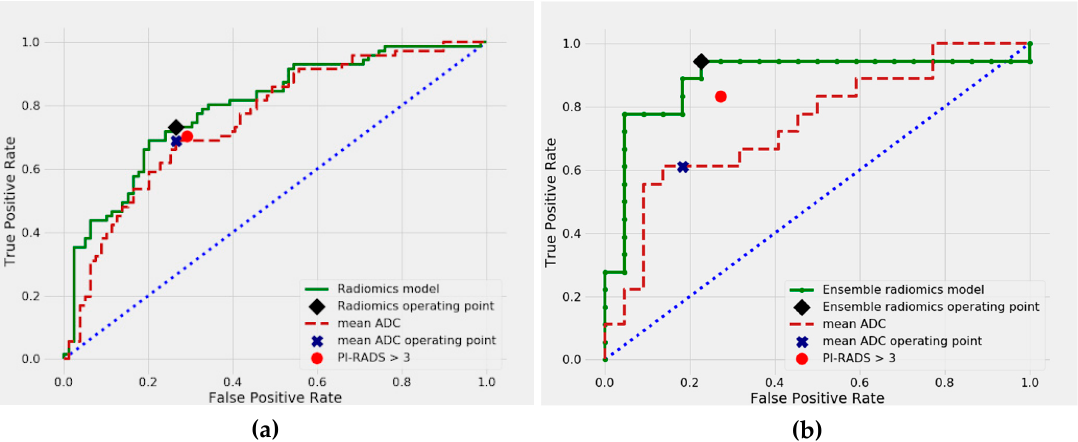
Figure 1. Receiver operating characteristics (ROC) curves for malignant vs. benign prostate lesion classification, in ( a ) 5-fold cross-validation, and ( b ) independent test set.